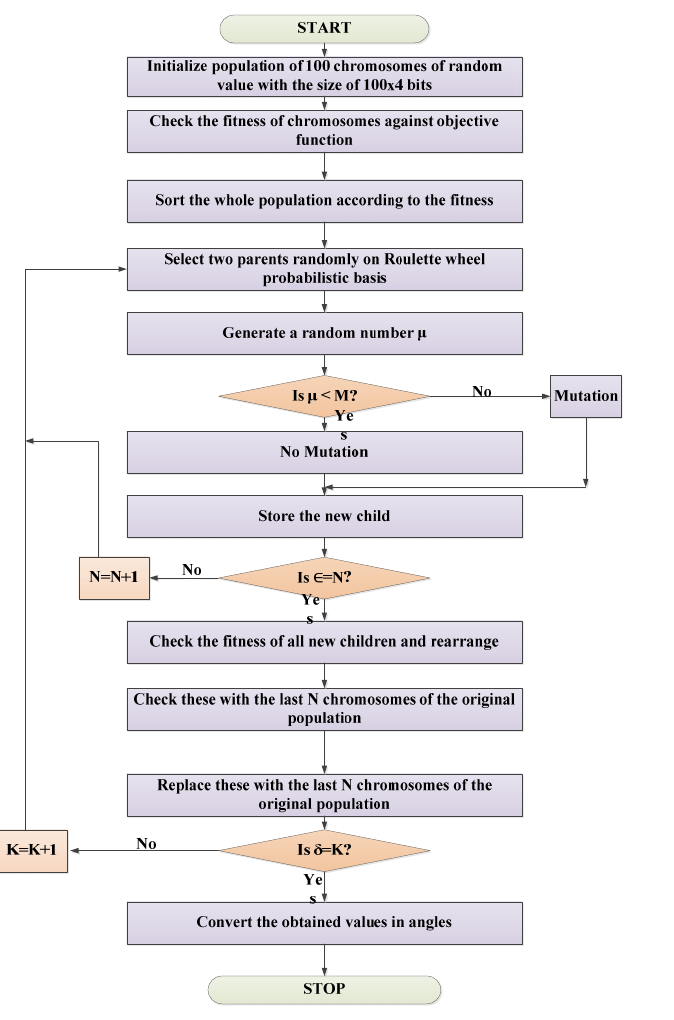
Figure 5. Flowchart of GA implementation.